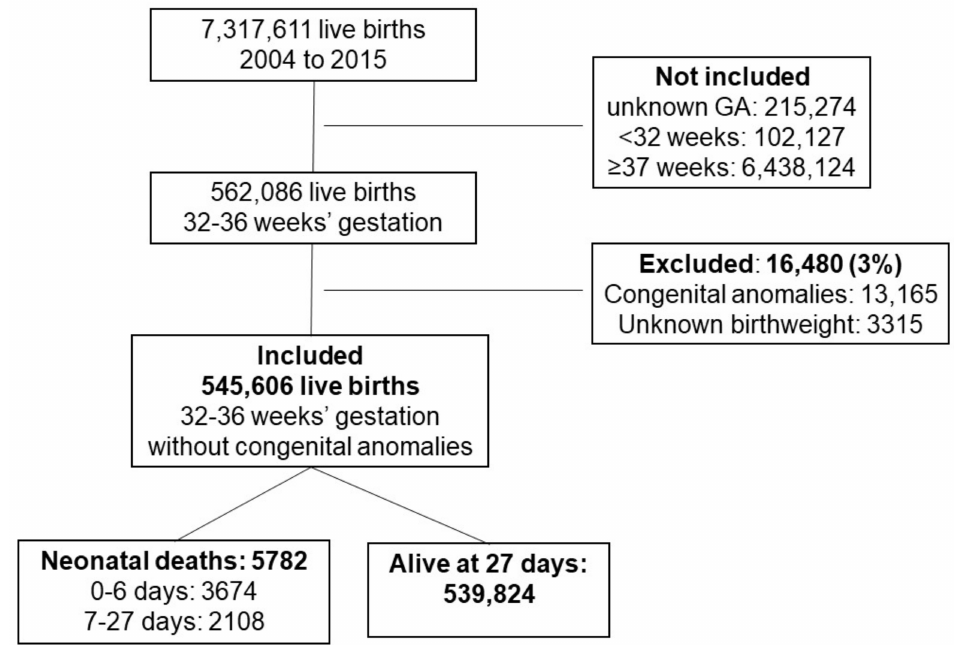
Figure 1. Flow diagram of the included infants in the study. The mortality rate decreased from 16.4 in 2004 to 7.6 per thousand live births in 2015 (Figure 2). The Prais–Winsten model showed an annual decrease of − 7.47% (95% CI: − 6.35 to − 8.58%) in the neonatal mortality rate of infants with 32 0/7 –36 6/7 weeks gestation without congenital anomalies. From 2004 to 2015, there was a decrease of 46% (95% CI 41–52%) in the neonatal mortality rate (Poisson regression analysis with robust variance; p <